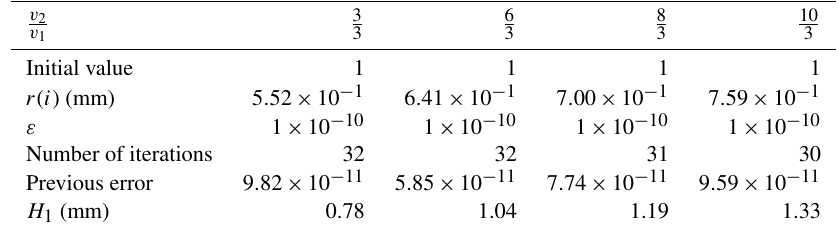
Table 1. Numerical solution of different wire-feeding speeds.